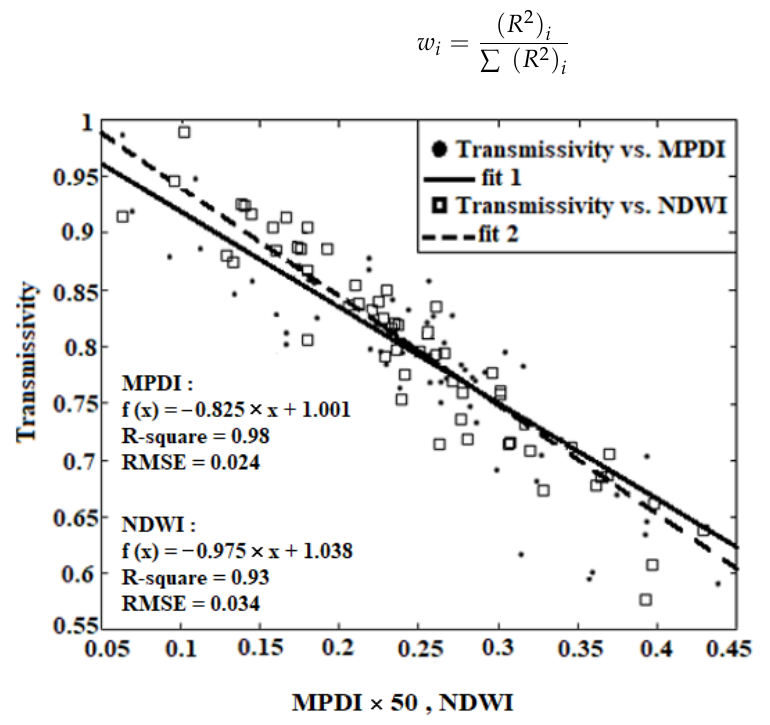
Figure 2. Scatter plots of MPDI and NDWI versus transmissivity using linear